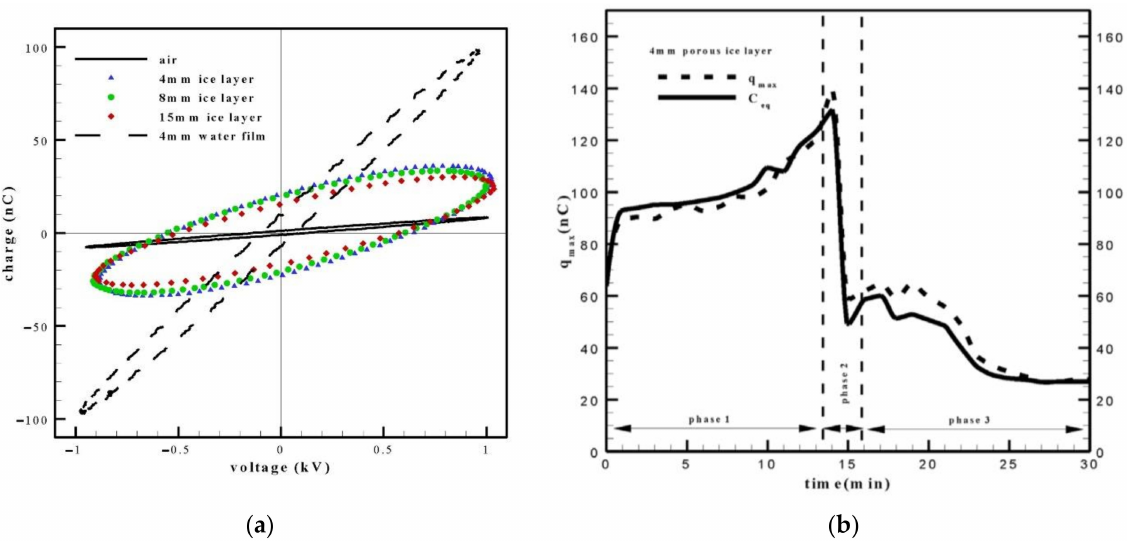
Figure 27. Variation in the plasma actuator electrical properties in the presence of different adjacent medium: ( a ) Variation in the DBD sensor/actuator charge in the presence of 4 mm, 8 mm, and 15 mm thick ice layer and a 4 mm thick water film. ( b ) Temporal variation in the DBD sensor/actuator capacitance and charge in the presence of an ice layer (reproduced from Abdollahzadeh et al. [30] with permissions of